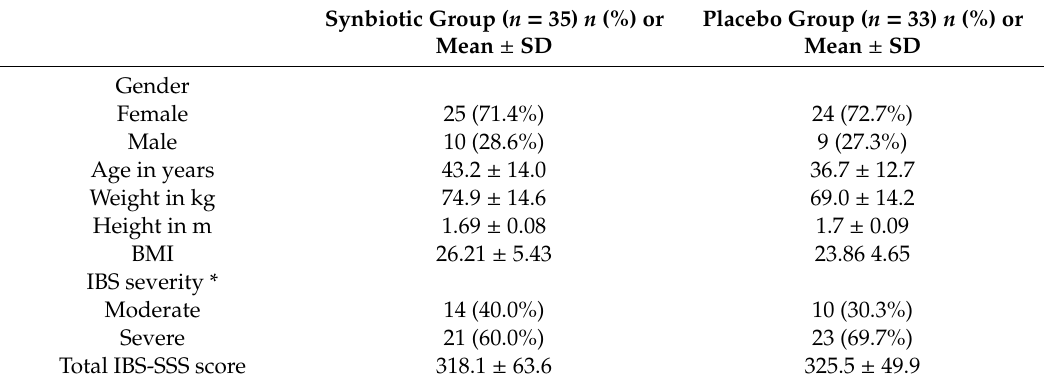
Table 3. Patient